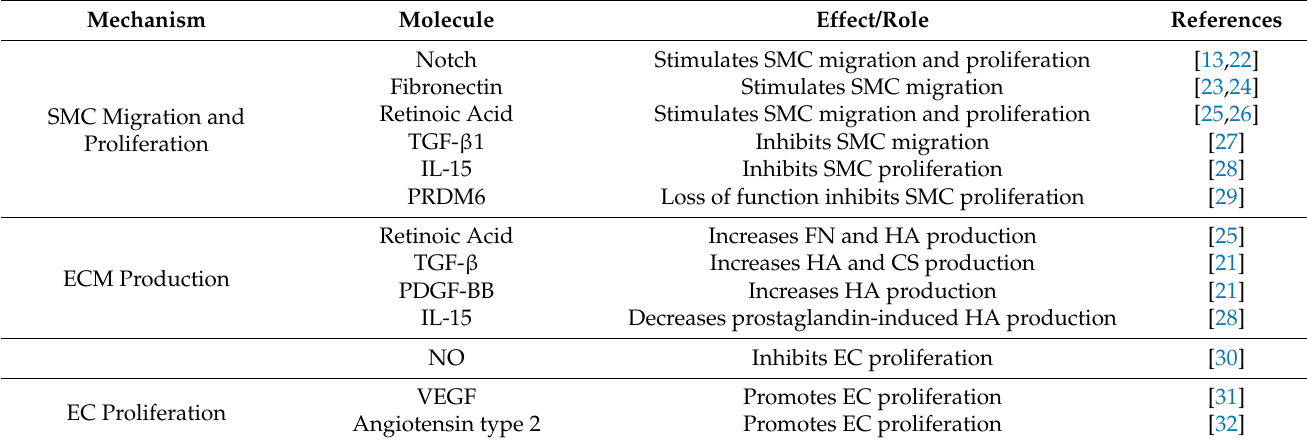
Table 1. Molecules involved in DA